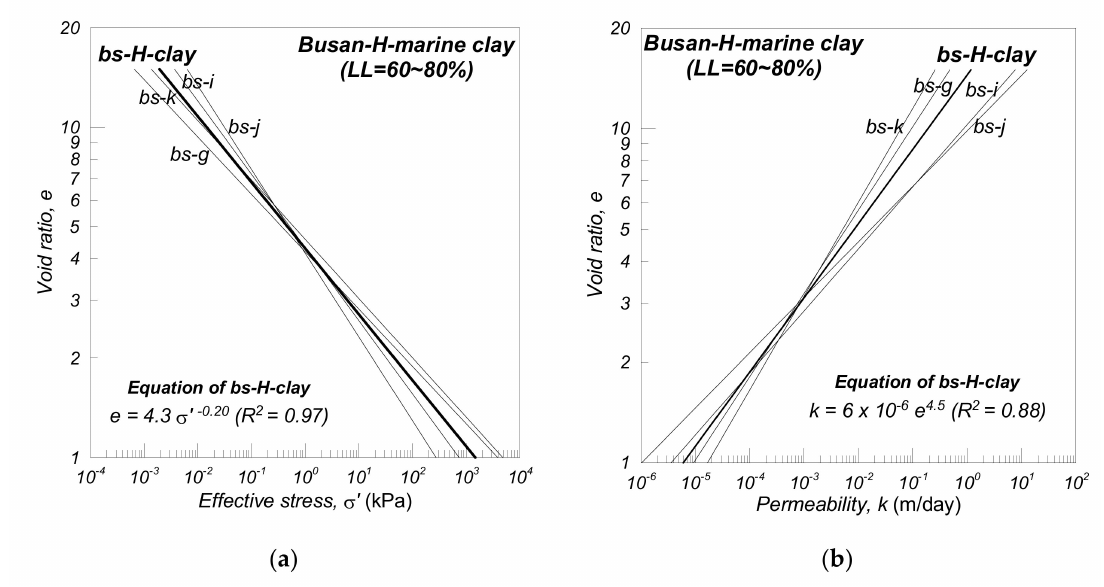
Figure 11. Constitutive relationship of Busan H marine clay (bs-H-clay): ( a ) void ratio vs. e ff ective stress; ( b ) void ratio vs.